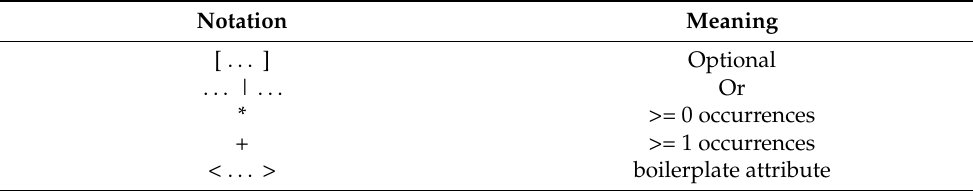
Table 1. Boilerplate Grammar